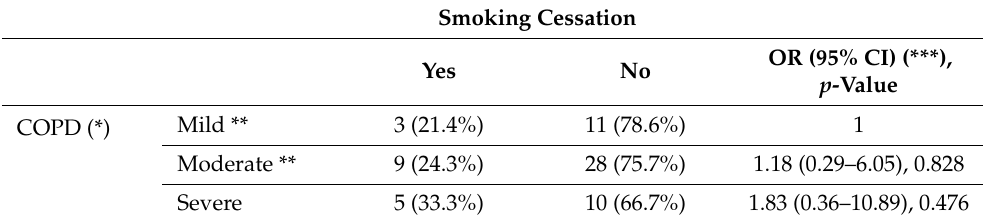
Smoking Cessation Yes